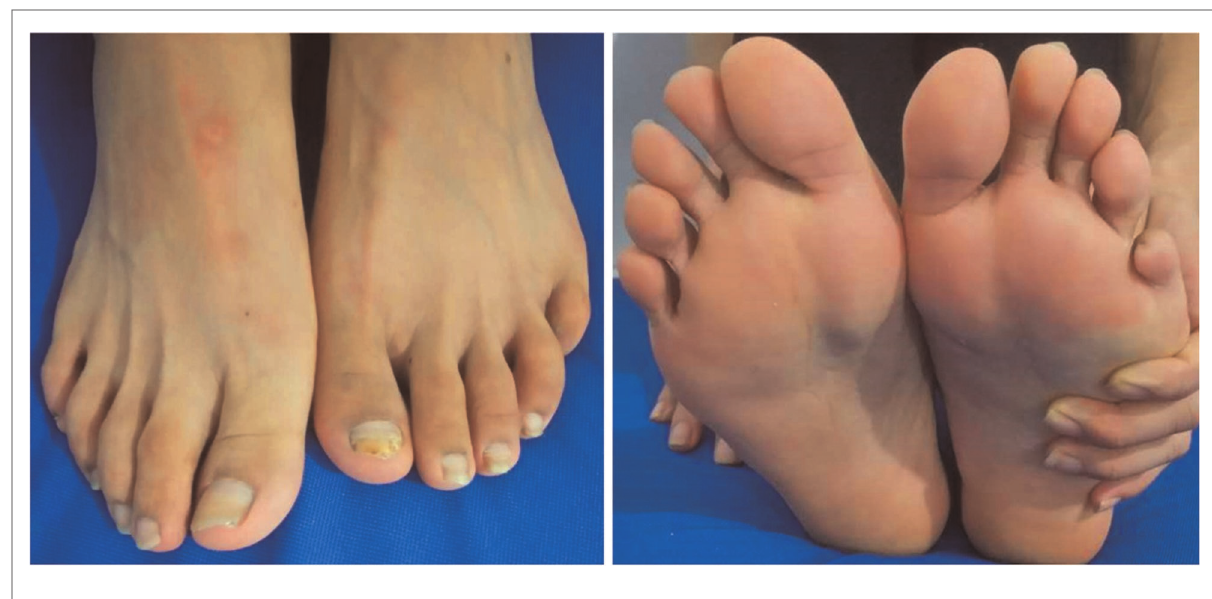
FIGURE 4 A photograph of the patient after treatment, showing his healed lower